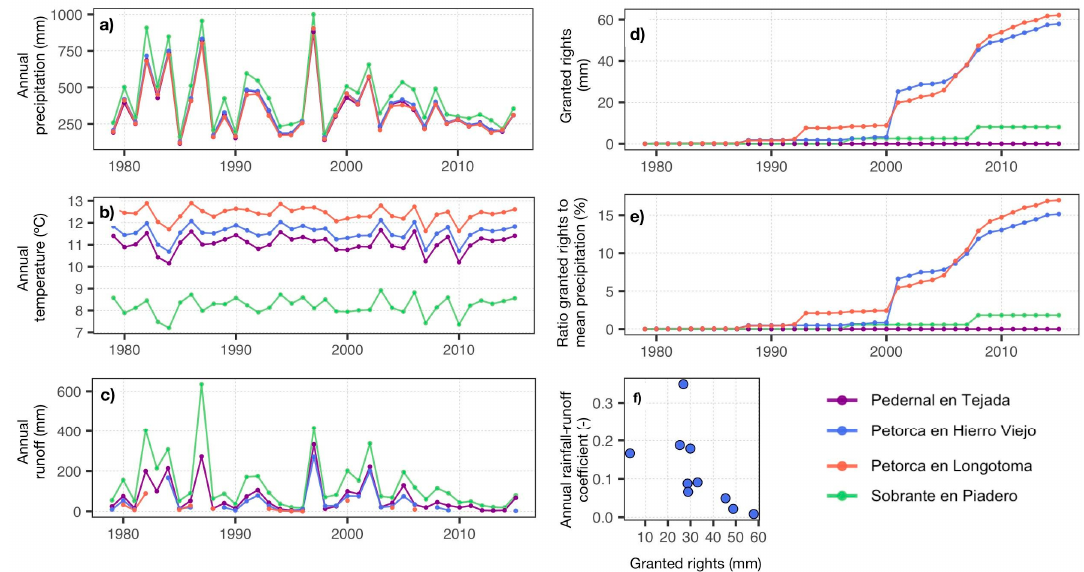
Figure 5. Time series of hydro-meteorological variables: ( a ) Annual precipitation, ( b ) annual temperature and ( c ) annual runo ff for each sub-catchment. Panel d shows the volume of accumulated granted rights (both surface and groundwater rights) and panel e shows the same volumes normalized by mean annual precipitation of the corresponding sub-basin. To make them comparable with precipitation and runo ff , we normalized the annual granted volume ( d ) and ( e ) by the corresponding catchment area. Panel ( f ) shows the annual rainfall-runo ff coe ffi cient (annual runo ff normalized by annual precipitation) related to the accumulated volume of granted rights for the corresponding year for Petorca en Hierro Viejo